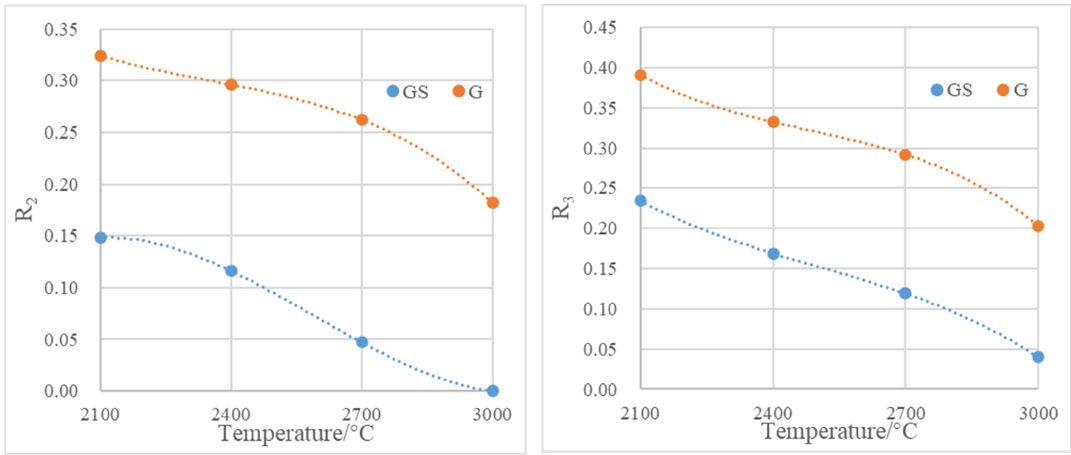
Figure 9. Raman parameter (R 2 and R 3 ) evolution characteristics with temperature. The R 3 parameter can reflect the overall defect percentage inside the sample lattice.